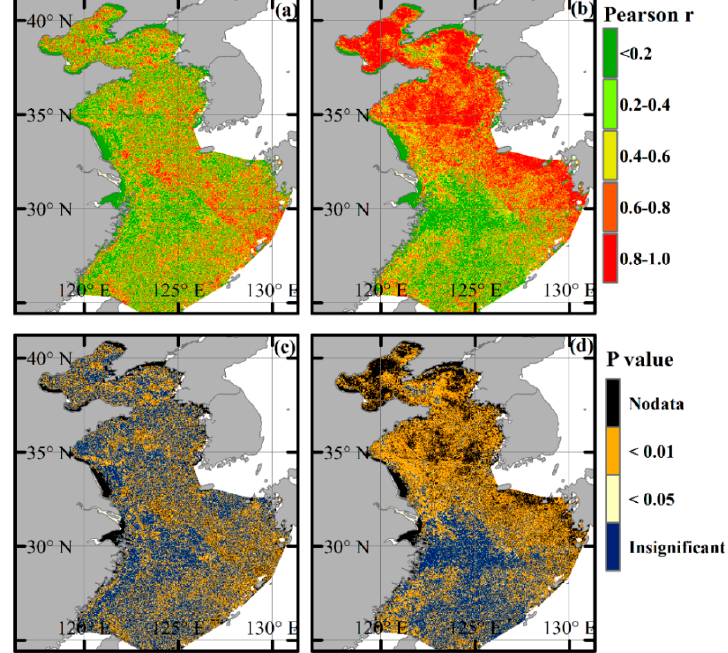
Figure 12. Partial correlation coe ffi cients ( P value) of TSS biases with cloud coverage ( a , c ), and TSS biases with TSS CV ( b , d ) at the hourly scale.